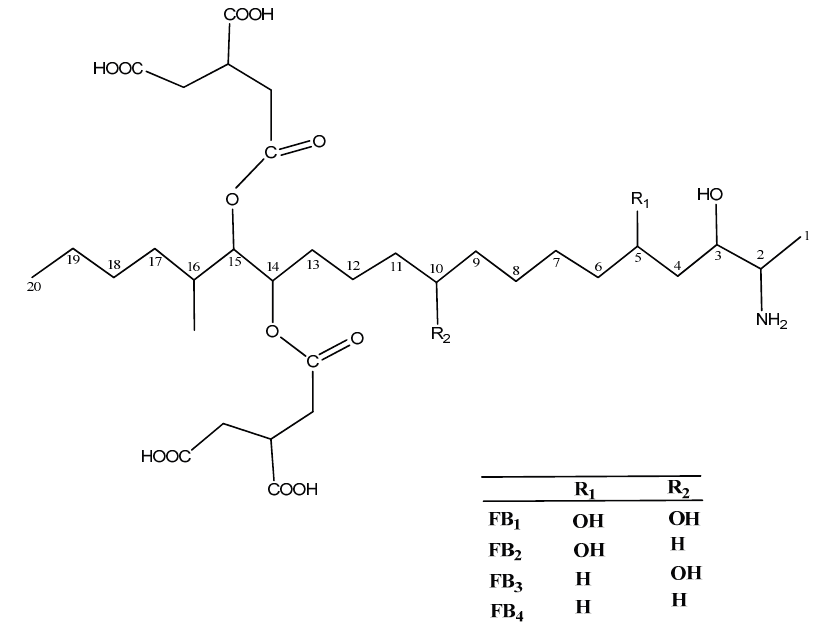
Figure 1. Chemical structure of